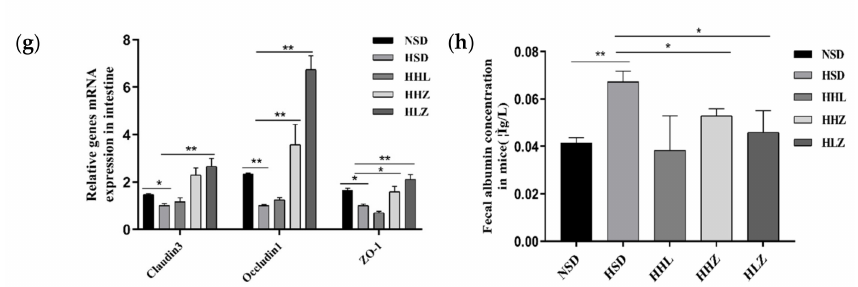
Figure 2. Lactiplantibacillus plantarum ZDY2013 can alleviate body damage caused by long-term high-salt diet. ( a ) Changes in body weight over time in each group. ( b ), HE pathological section of mouse colon tissue. ( c ) HE pathological section of mouse kidney tissue. ( d ) The histograms of Masson’s trichromatic staining and the histograms of fibrosis score in mouse kidney tissue. ( e ) Expression of related cytokines mRNA in the intestinal tract of mice. ( f ) mRNA expression of cytokines in kidney tract of mice in different groups. ( g ) Expression of tight junction protein mRNA in the intestinal tract of mice. ( h ) Fecal albumin concentration in mice. All data are presented as mean ± SD. * p < 0.05; ** p < 0.01; *** p < 0.001; **** p < 0.0001; paired two-tailed t